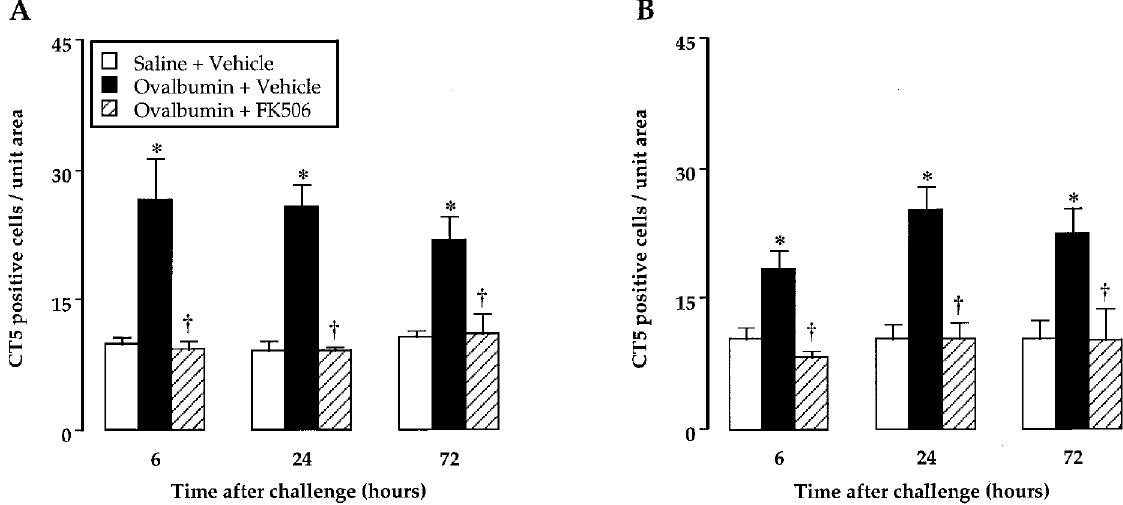
FIG. 4. Time-course of the effect of FK506 on antigen-induced T-lymphocyte accumulation in the bronchial submucosa (panel A) and in the adventitia (panel B) from sensitized guinea-pigs (CT5 staining and APAAP). Sensitized vehicle-or FK506 (0.5mg/ kg)-treated animals were challenged with aerosolized saline or ovalbumin and lungs collected 6, 24 or 72h thereafter. Results are means ± SEM of six experiments. * P < 0.05, compared with saline-challenged vehicle-treated guinea-pigs. † P < 0.05, compared with ovalbumin-challenged vehicle-treated